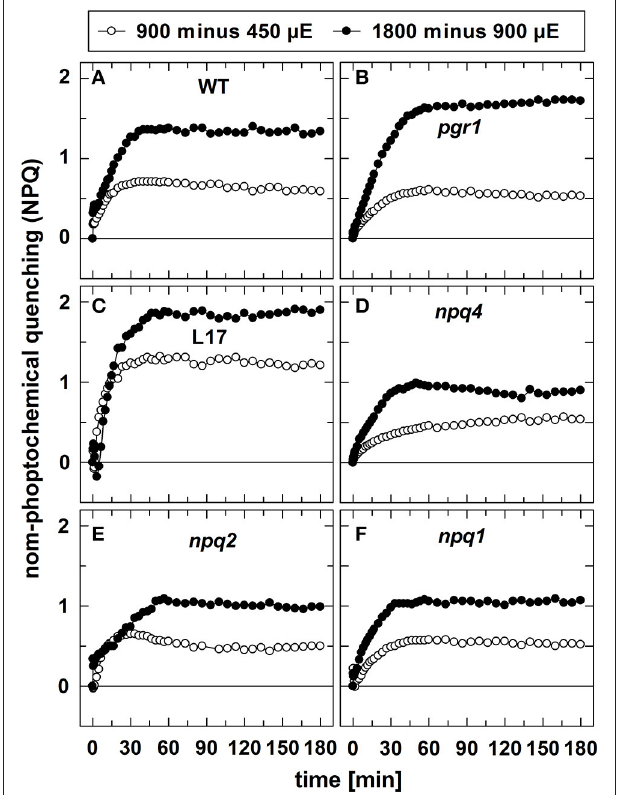
FIGURE 2 | Differences in NPQ induction upon increase of light intensities . To visualize the differences in NPQ induction upon increase of the actinic light intensity from either 450 to 900 µ E or from 900 to 1,800 µ E, the differences of the respective curves shown in in Figure 1 were plotted for all genotypes. (A) WT, (B) pgr1 , (C) L17 , (D) npq4 , (E) , npq2, and (F) npq1